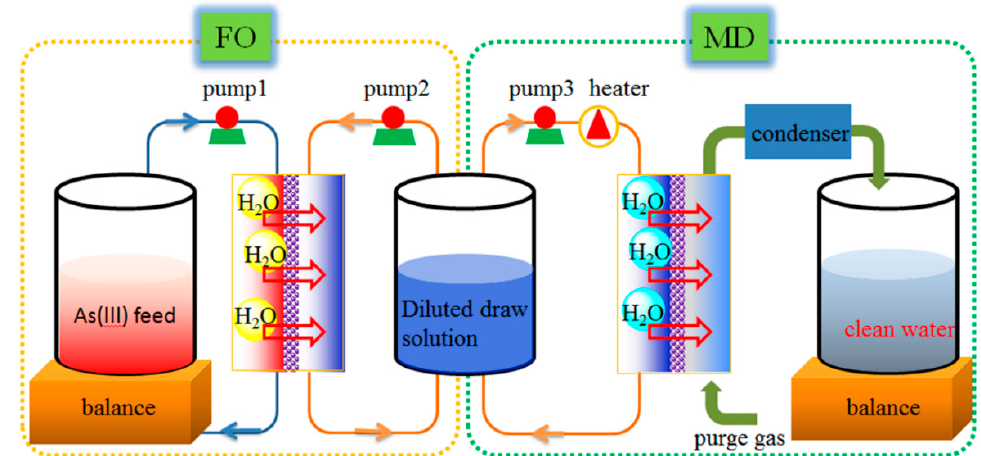
Figure 2. Schematic illustration of using a hybrid FO - MD process for wastewater treatment.